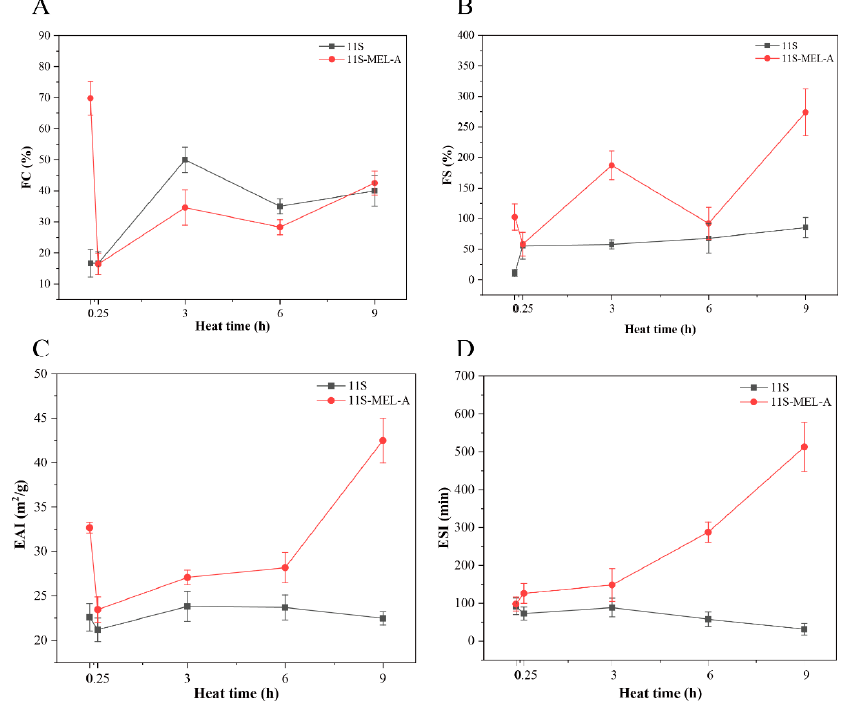
Figure 2. FC ( A ) and FS ( B ) of the 11S and 11S-MEL-A mixtures depend on the heat treatment time. EAI ( C ) and ESI ( D ) of the 11S and 11S-MEL-A mixtures as a function of the heat treatment time.